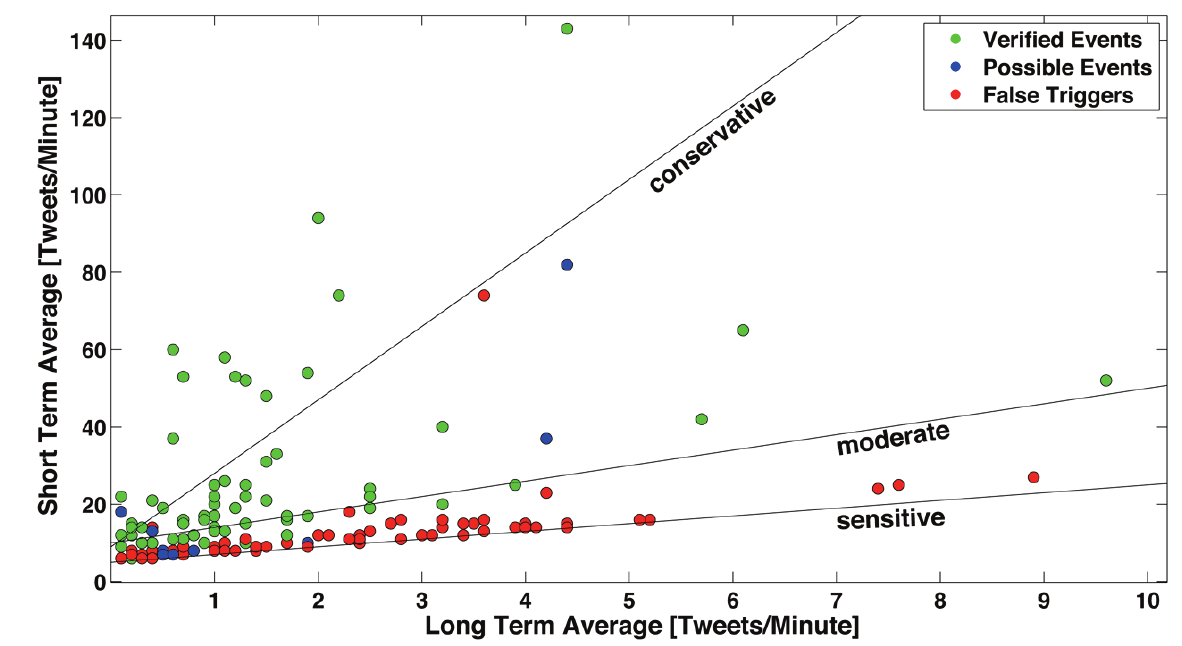
Figure 3. Recorded STA versus LTA for events in our dataset. Green dots, ‘verified’ earthquakes; blue dots, ‘possible’ earthquakes; red dots, ‘false’ triggers (see text for details). Note that these STA and LTA values correspond to where the characteristic function reaches its highest value following a trigger. The three lines are defined as STA = m * LTA + b and represent the three trigging thresholds discussed in the text. Events above a given line will trigger a detection for the corresponding trigger sensitivity. More conservative thresholds produce a higher ratio of verified to false triggers.